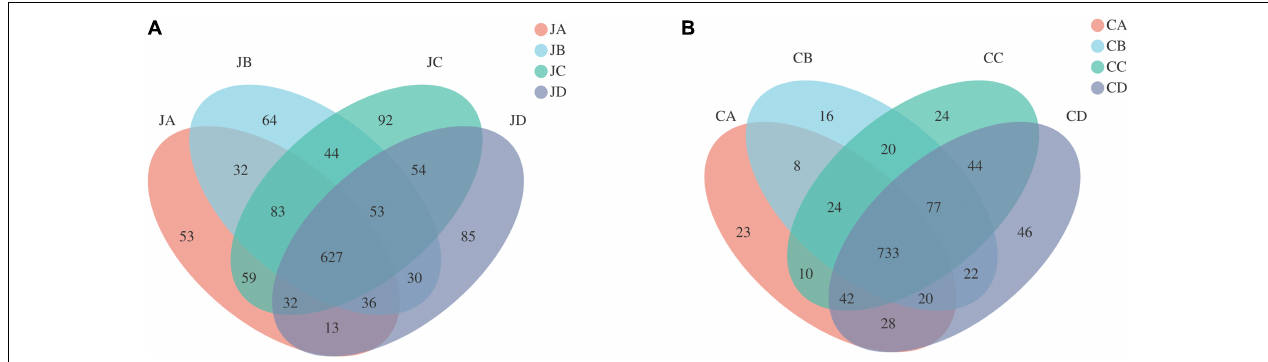
FIGURE 2 | Shared and specific operational taxonomic unit (OTUs) in different intestinal sections of different groups ( A : jejunum; B : cecum). JA, jejunum of 0% HILM; JB, jejunum of 1% HILM; JC, jejunum of 3% HILM; JD, jejunum of 5% HILM; CA, cecum of 0% HILM; CB, cecum of 1% HILM; CC, cecum of 3% HILM; CD, cecum of 5%